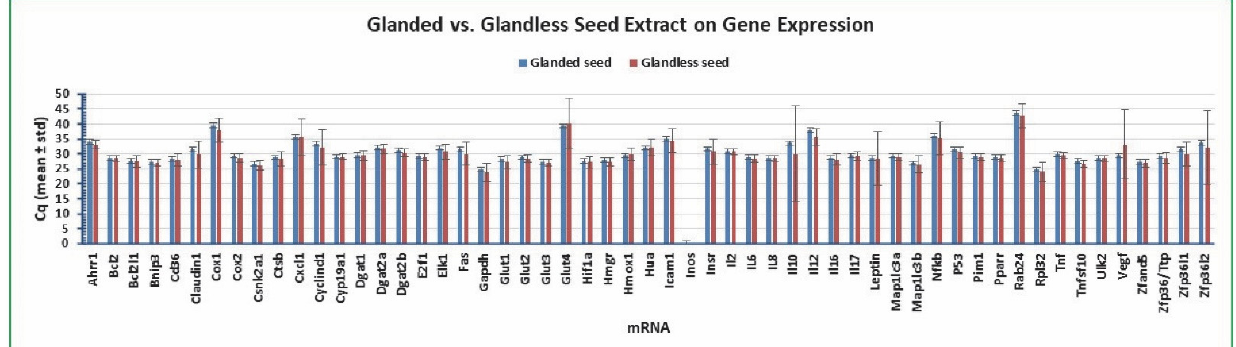
Figure 5. Variation of gene expression between glanded and glandless cottonseed extract treatment. The cancer cells were treated with multiple concentrations of cottonseed extracts (0, 5, 10, 20, 30, 40, 50, and 100 µg/mL) for 8 h. Total mRNAs were extracted from the cells, converted into cDNAs, and the relative abundance was analyzed by SYBR Green qPCR. The Cq values represented the mean and standard deviation of 48 independent samples.